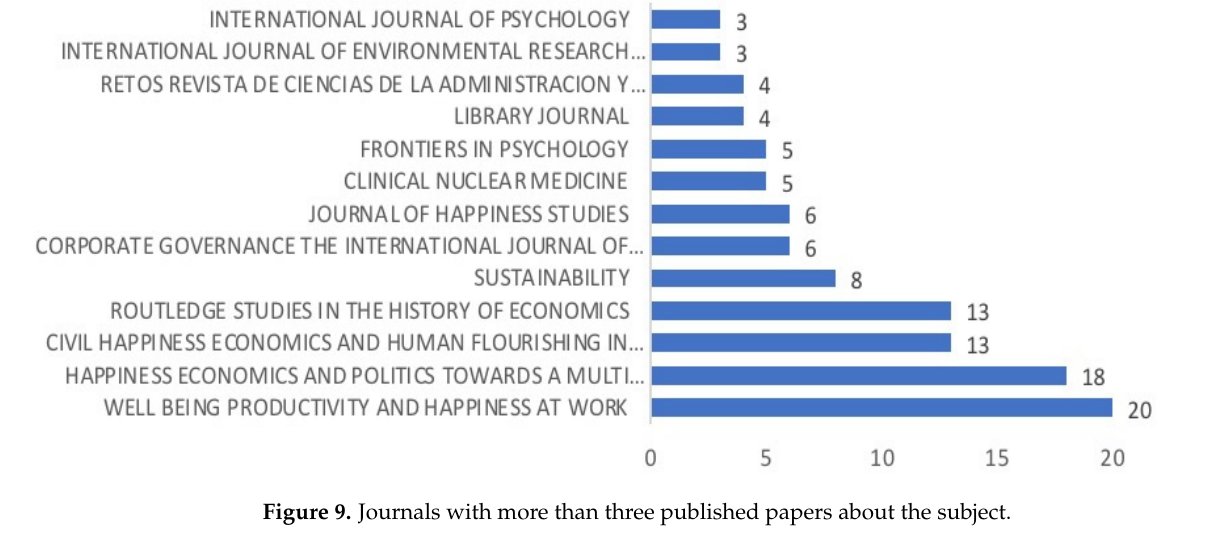
Figure 9. Journals with more than three published papers about the subject.